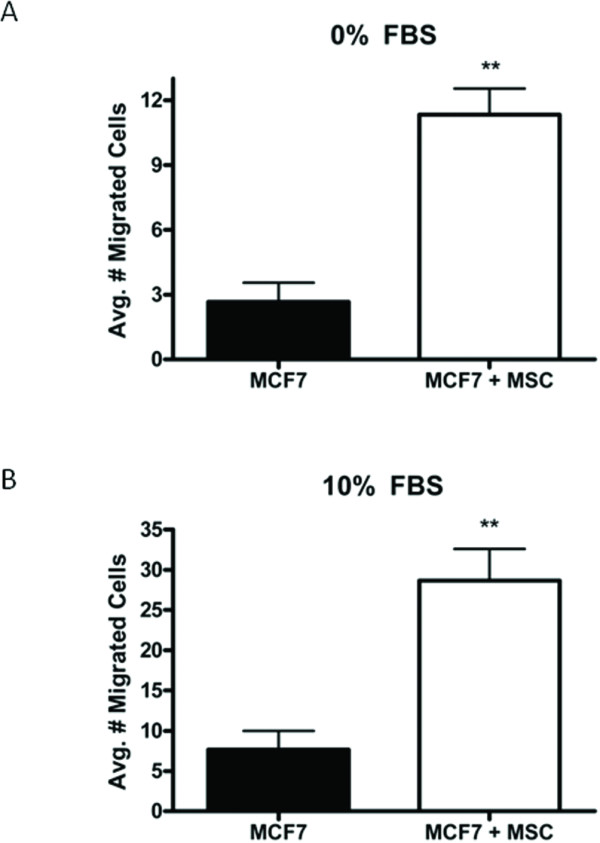
hMSCs increase migration of MCF-7 cells in vitro. MCF-7-GFP cells alone or in combination with hMSCs (1:1) were seeded in the upper chamber of a transwell system and treated with DMSO. Lower wells contained either (A) serum-free culture media (0%) or (B) culture media supplemented with 10% FBS (10%). After 48 hours cells were fixed and the number of GFP-positive migrated cells counted. Bars represent average number of migrated cell per condition ± SEM, (** p < 0.01).